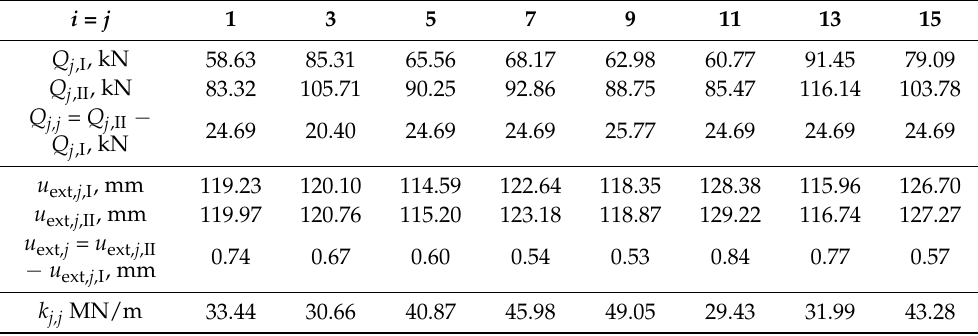
Table A2. Stiffness k j,j determined from in-situ tests according to (1) at points at the foundation